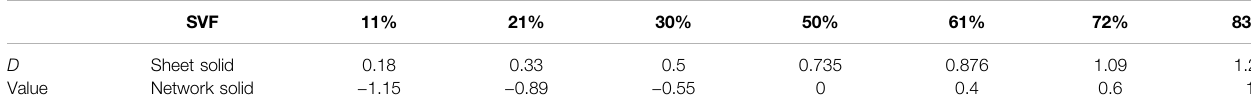
TABLE 1 | Relationship between d and SVF for the Gyroid TPMS sheet solid and network solid.